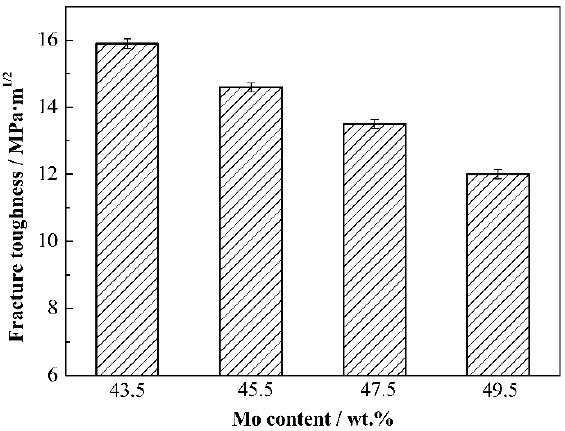
Figure 10. Fracture toughness of Mo 2 FeB 2 based cermets with different Mo contents.